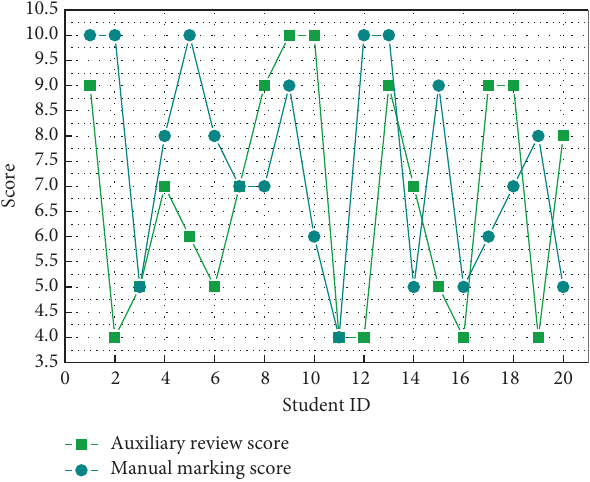
Figure 4: Root mean square error of scores.